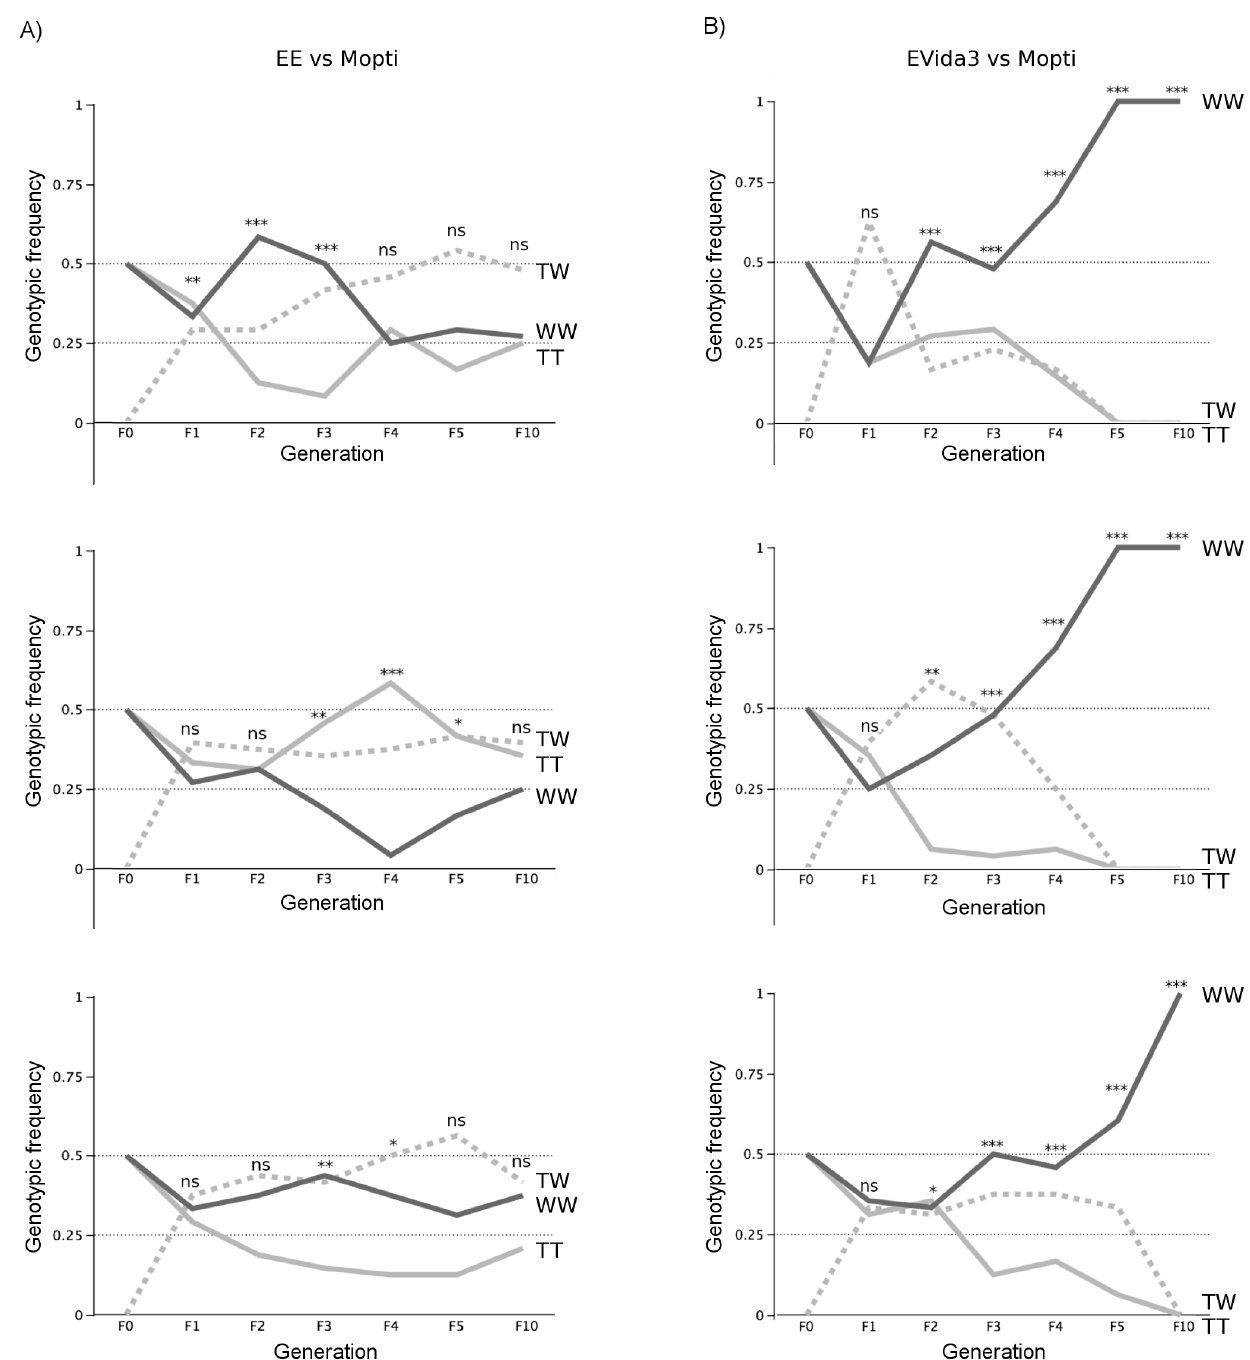
Figure 3. Frequency of hemizygotes, homozygous transgenic and homozygous wild-type genotypes over 10 generations in three independent replicates. In A) the frequency of individuals homozygous (TT) and hemizygous (TW) for the Phase-1 EE docking construct are compared to homozygous wild-type (WW); in B) the frequency of homozygotes (TT) and heterozygotes (TW) for the Phase-2 EVida3 construct are compared to homozygous wild-type (WW). Significance levels of a Chi-square test of HWE are indicated - ns, not significant, *: P , 0.05, ** P , 0.01, *** P , 0.001. doi:10.1371/journal.pone.0067364.g003 2 3.0, P = 0.850; TT-WW: n =12, Z = 19.0, P = 0.151) and pupae 2 27.0, P = 0.034) and homozygous EVida3 transgenics ( Z = 2 30.0, P = 0.016) were significantly reduced (Fig. 5B). to adult stages (Wilcoxon signed-rank tests: TW-WW: n = 12, Z = 2 10.0, P =0.457; TT-WW: n = 12, Z = 19.0, P = 0.151) develop- mental periods (Fig. 5B). However during development from L 1 larvae to pupae the relative fitness of both the hemizygous ( Z =